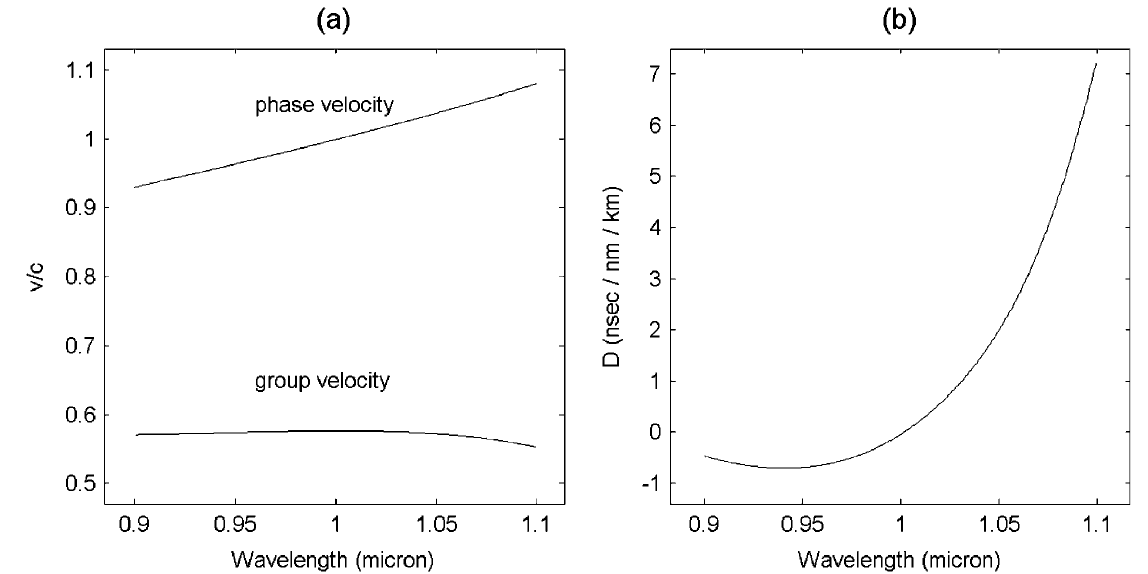
FIG. 7. (a) Phase velocity, group velocity, and (b) dispersion parameter of the TM defect mode as a function of free-space wavelength for Lin PBG fiber ( a ¼ 1 : 3 micron ) as calculated with the multipole